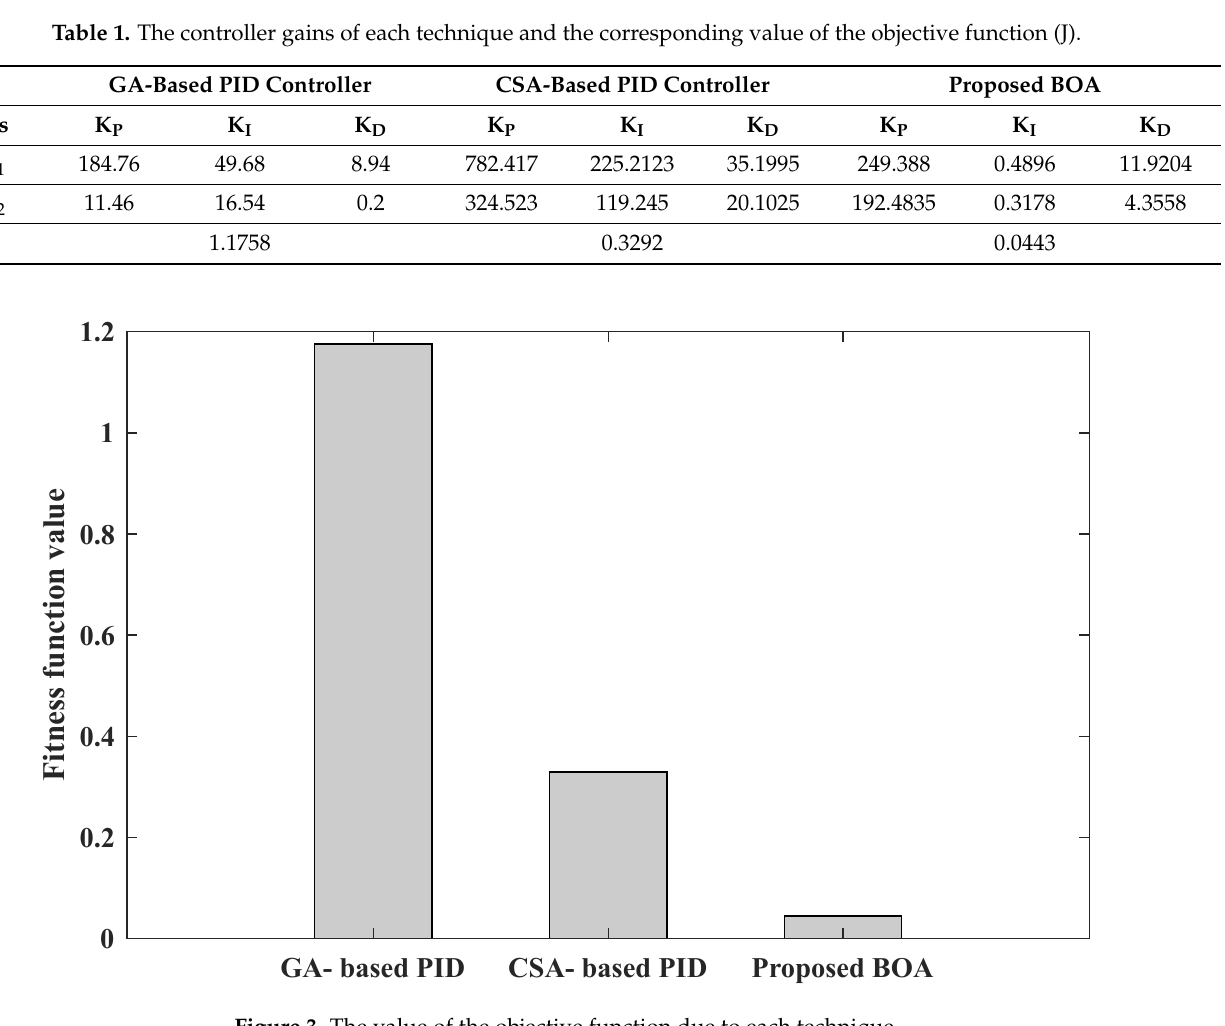
Figure 3. The value of the objective function due to each technique.